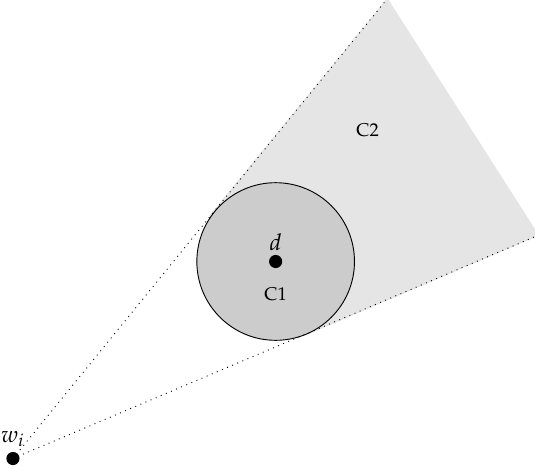
Figure 1. The two condition areas in which the next waypoint shall be to turn u into an FN.